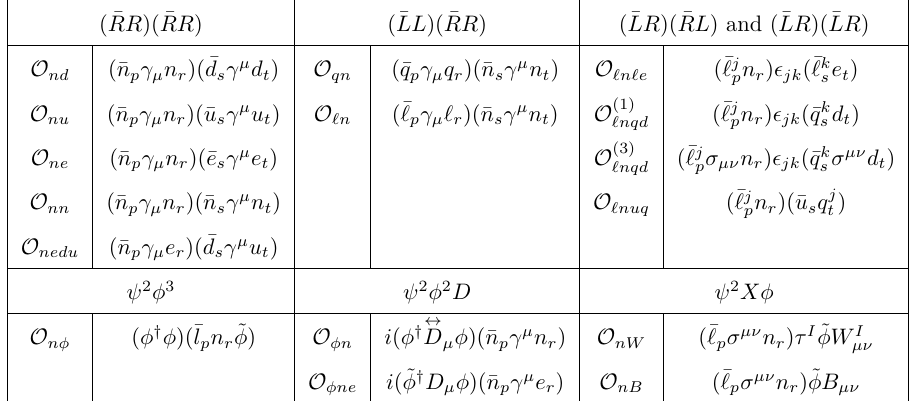
Table 1 . The 16 SMNEFT operators involving RH neutrinos n in the Warsaw basis convention which conserve baryon and lepton number (∆ B = ∆ L = 0) . The flavor indices ‘ prst ‘ on the operators are suppressed for simplicity. The fundamental SU(2) is the adjoint